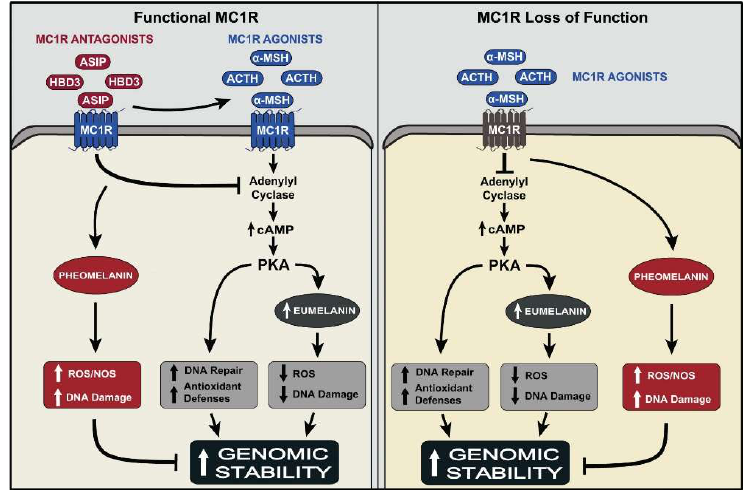
Figure 1. Summary of the effects of the MC1R agonists α-MSH and ACTH and the antagonists ASIP and HBD3 on functional MC1R, and the impact of loss of function of MC1R on these effects. Activation of the MC1R, expressed on the cell membrane of melanocytes by either agonist, α-MSH or ACTH activates the cAMP pathway, leading to increased eumelanin synthesis, which quenches reactive oxygen species (ROS) and reduces the generation of DNA damage upon UV exposure. Activation of the cAMP pathway also enhances the DNA repair and antioxidant capacities of melanocytes. The cumulative outcome of these effects is maintenance of genomic stability of melanocytes. Treatment of melanocytes with either ASIP or HBD3 antagonizes the effects of α-MSH, and are therefore expected to reduce genomic stability. Expression of loss-of-function-MC1R disrupts the signaling of the agonist-bound receptor, thereby inhibiting the synthesis of eumelanin, allowing only the synthesis of pheomelanin, which increases the generation of ROS and NOS, and allows for increased UV-induced DNA damage. Additionally, lack of signaling of the α-MSH-bound MC1R via the cAMP pathway inhibits the activation of antioxidant and DNA repair pathways, leading to reduced genomic stability of UV-irradiated melanocytes, and increased risk for malignant transformation to melanoma. Upward arrows: increase in the effect; T bar: blocking the effect.